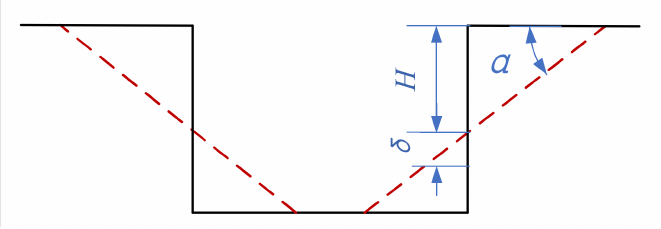
Figure 19. The starting position of the third-stage forming.